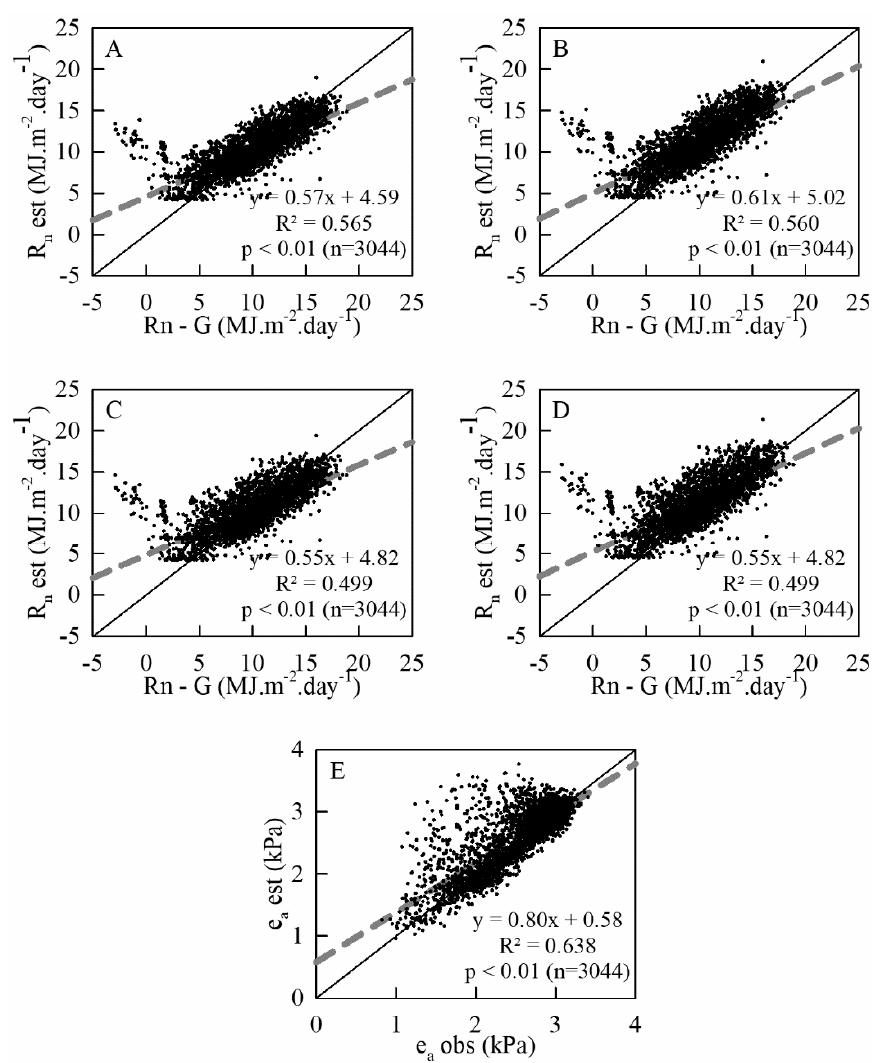
Figure 6. Linear regressions of ( A ) R n estimates using calibrated parameters and real e a ; ( B ) R n esti- mates using recommended parameters and real e a ; ( C ) Rn estimates using calibrated parameters and estimated e a ; and ( D ) R n estimates using recommended parameters and estimated e a , in comparison with real values of R n − G ; and ( E ) a linear regression of estimated e a versus observed values. The central line represents a 1:1 correlation and the dashed line represents the linear regression through the origin.